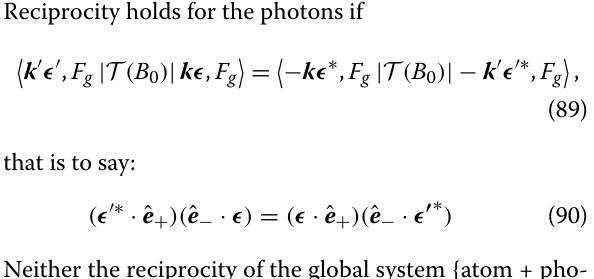
Fig. 4 The very low CBS enhancement factor observed with a sample of 85 Rb atoms can be significantly increased by subjecting the atoms to a magnetic field and cranking up its strength, see [44, 45]. The trick is to isolate a given atomic transition from its neighbouring ones and tune the incoming light at resonance with this transition. The atomic system then behaves like a two-level system without degeneracies and reciprocity is effectively restored. The maximal CBS contrast of 2 is not reached at large magnetic fields, although the amplitudes of the interfering scattering paths become equal, because the single scattering signal cannot be filtered out due to magneto-optical effects. Black circles: CBS enhancement factors measured in the experiment. Black solid line: Numerical theory simulation without any adjustable parameters. The inset shows the coherent backscattering cones measured at B = 0 (1) and at B = 43 G (2) in the